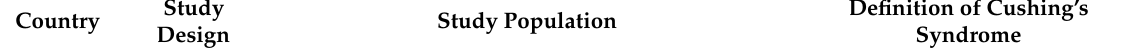
Table 1. Study characteristics of eligible studies.